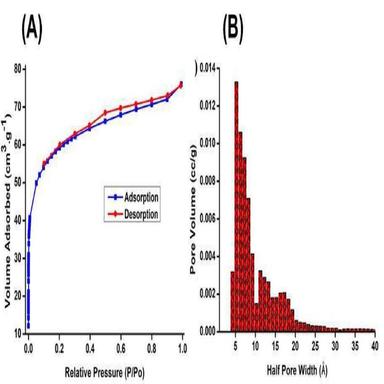
(A) N2 adsorption-desorption isotherms (B) Pore volume distribution plot of Cu-ACC.